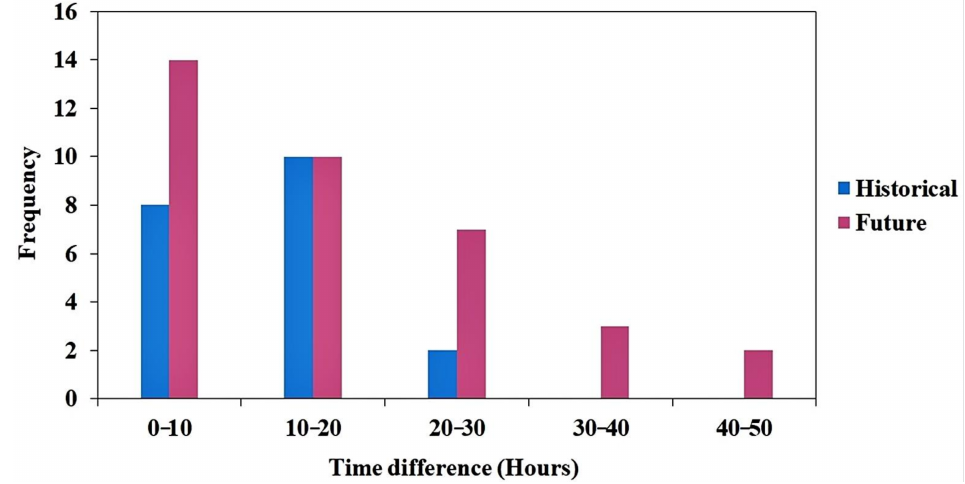
Figure 10. Frequency of time difference in the CRB for the top 20 rainfall events (historical simulation) and top 36 rainfall events (future